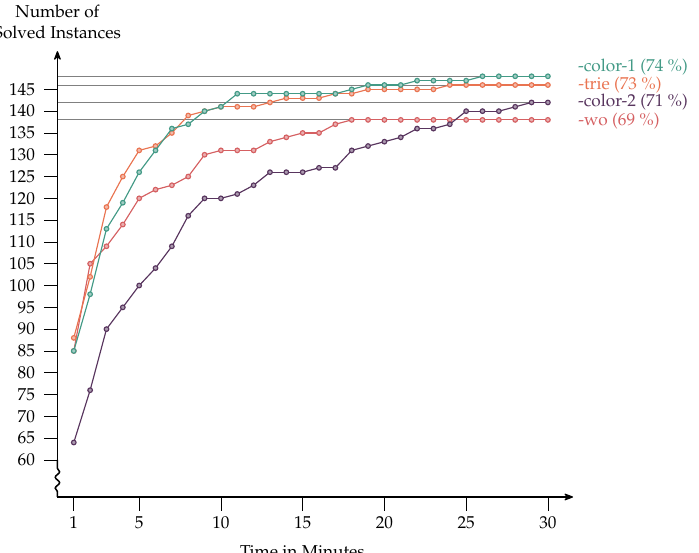
Figure 9. tba Figure 9. A cumulative distribution function plot that shows the performance of PID (cid:63) without color coding sieves (-wo), with just the lazily built set trie (-trie), with the full color coding sieve and γ = 1 (-color-1), and with the full color coding sieve and γ = 2 (-color-2). The experiments are performed on the set of 210 hyperbolic random graphs described in Table 1.